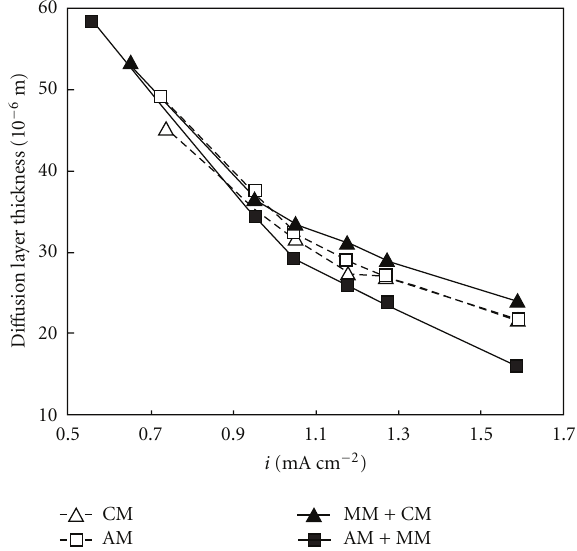
Figure 7: Di ff usion layer thickness versus current density. Symbols are inserted in the